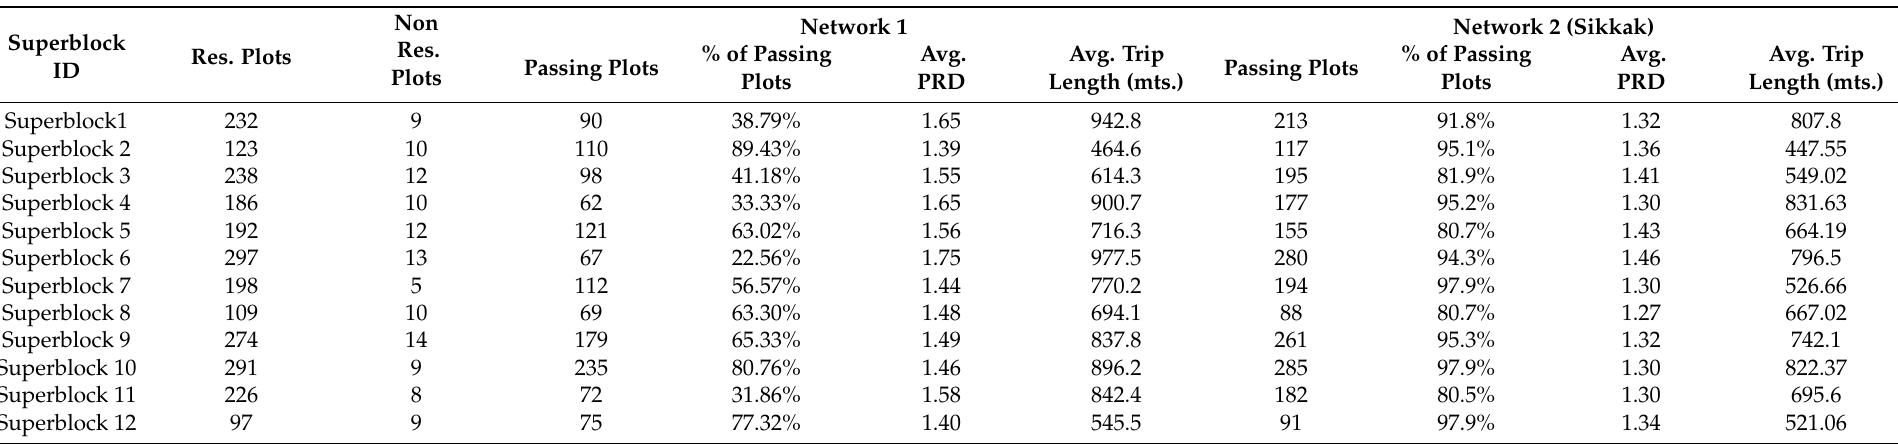
Table 3. Descriptive statistics of the all-residential-plots-to-all-non-residential-plots route directness analysis of Network 1 in column (3–6). Results of Network 2—the network that includes Sikkak—are presented in columns